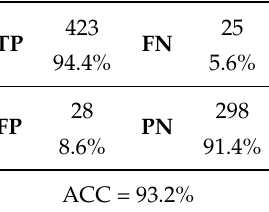
Figure 9. PKSlots dataset ( a ) Positive samples; ( b ) Negative samples. Table 5. Confusion matrix for PKSlots dataset, t = 8.